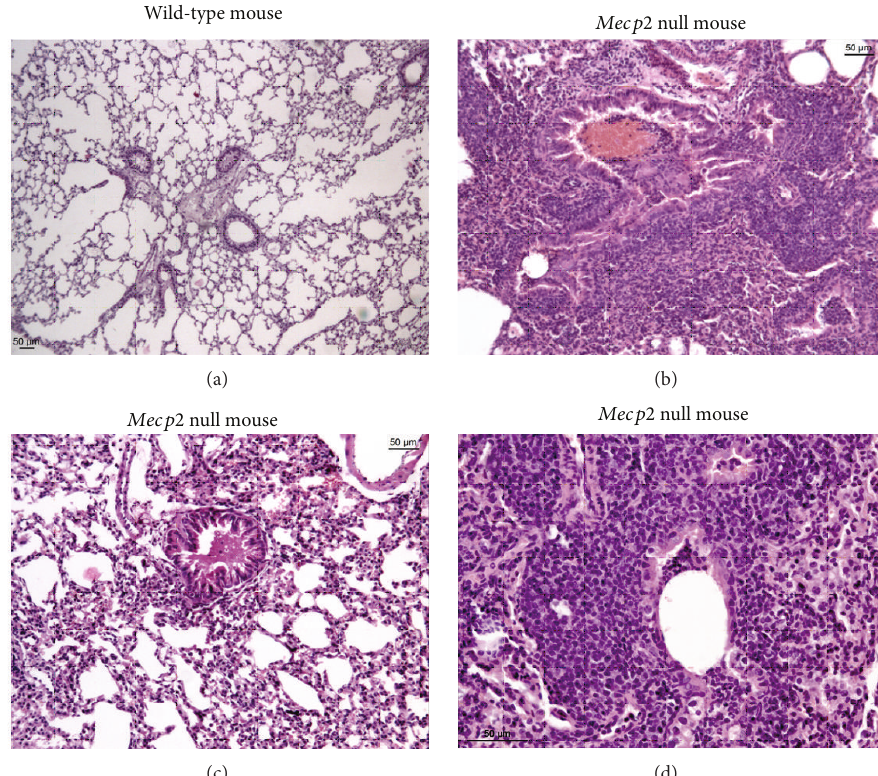
Figure 3: Lymphocytic bronchiolitis and desquamative alveolitis in Mecp2 null mice. (a) Wild-type mouse lung: normal histological features (magnification 25x), (b) Mecp2 null mouse: peribronchiolar lymphocyticinfiltrate (magnification 50x), (c) Mecp2 null mouse lung: desquamative alveolitis with mild amount of alveolar exudate (50x), and (d) Mecp2 null mouse lung: terminal bronchiolitis at higher magnification (200x) lymphocytes and histiocytes infiltrates outside and inside thickened terminal bronchioles, with a resulting picture of lymphocytic